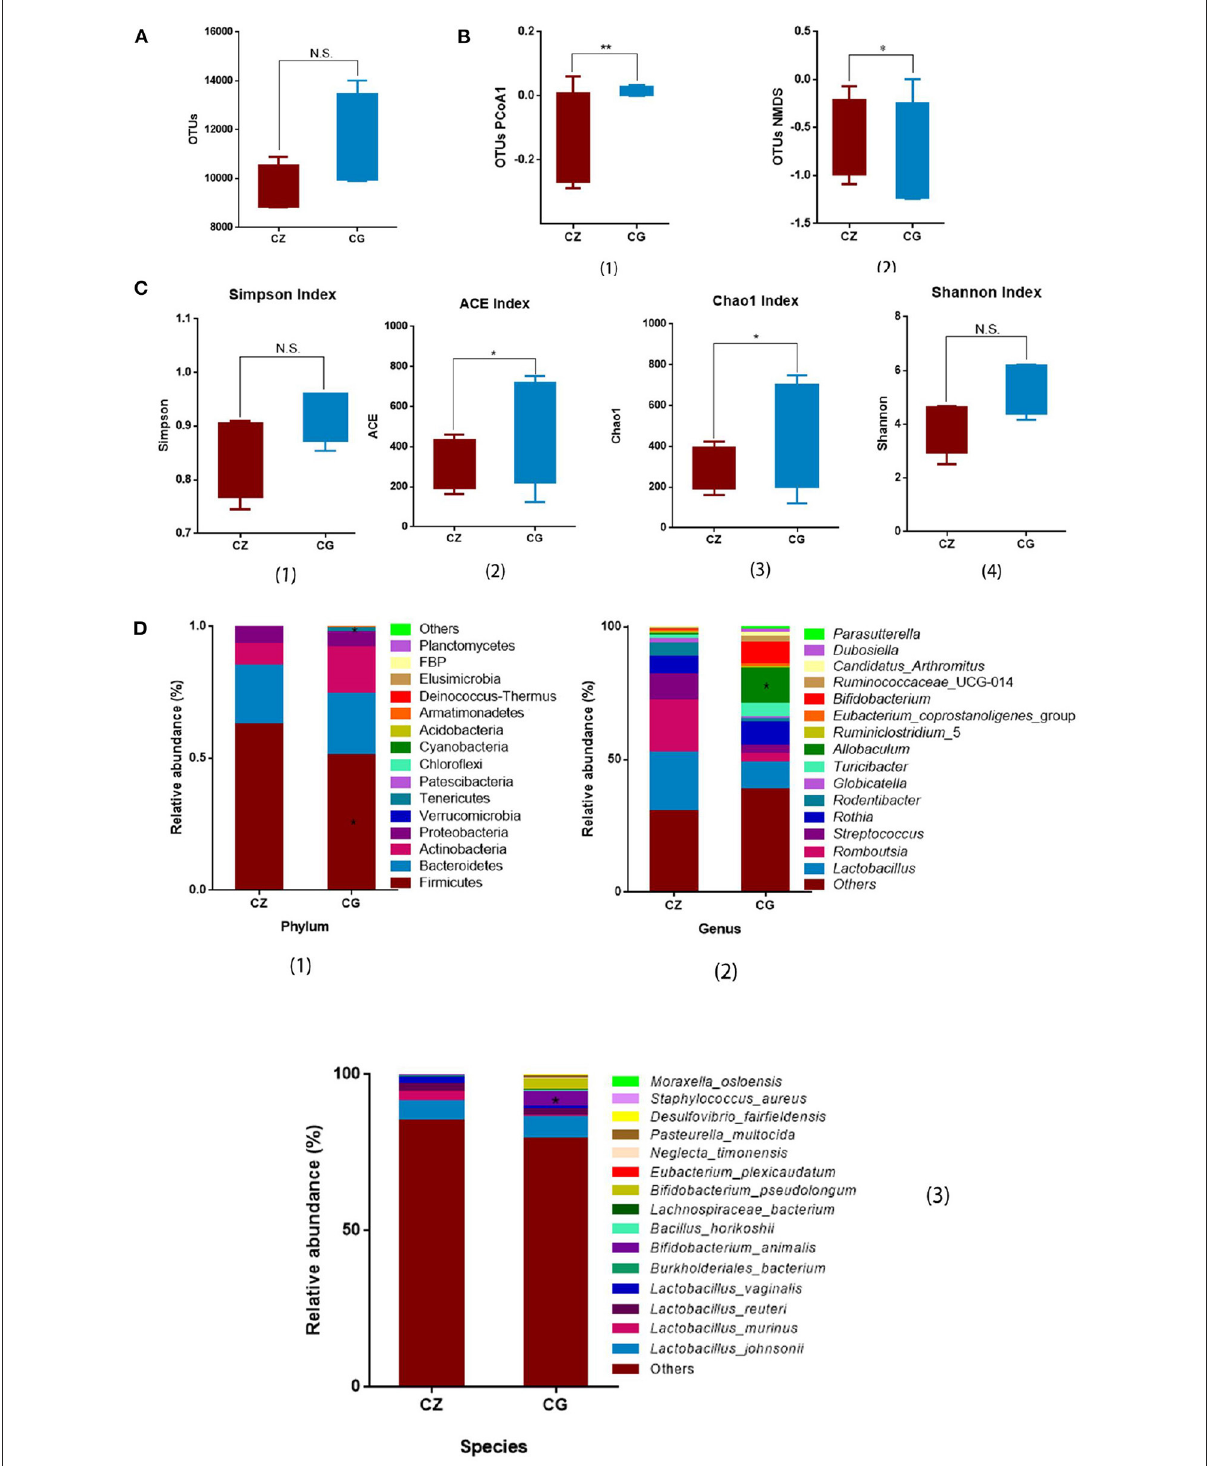
FIGURE1 Hypertension of liver-Yang hyperactivity syndrome induced by a high salt diet alters intestinal microbiota diversity and composition. (A) Bar plots of observed operational taxonomic unit (OTUs). (B) Box plots of β - diversity index of PCoA1 and NMDS of OTUs, represented by the space distance among groups. (C) Bar plots of α - diversity index of OTUs (Chao1, Simpson, ACE, and Shannon). (D) Relative mean abundance of (1) phyla, (2) genus and (3) species in the intestinal contents, (A–D) * P < 0.05, ** P < 0.01; N.S., not significant ( P > 0.05). CZ, normal group, CG, hypertensive